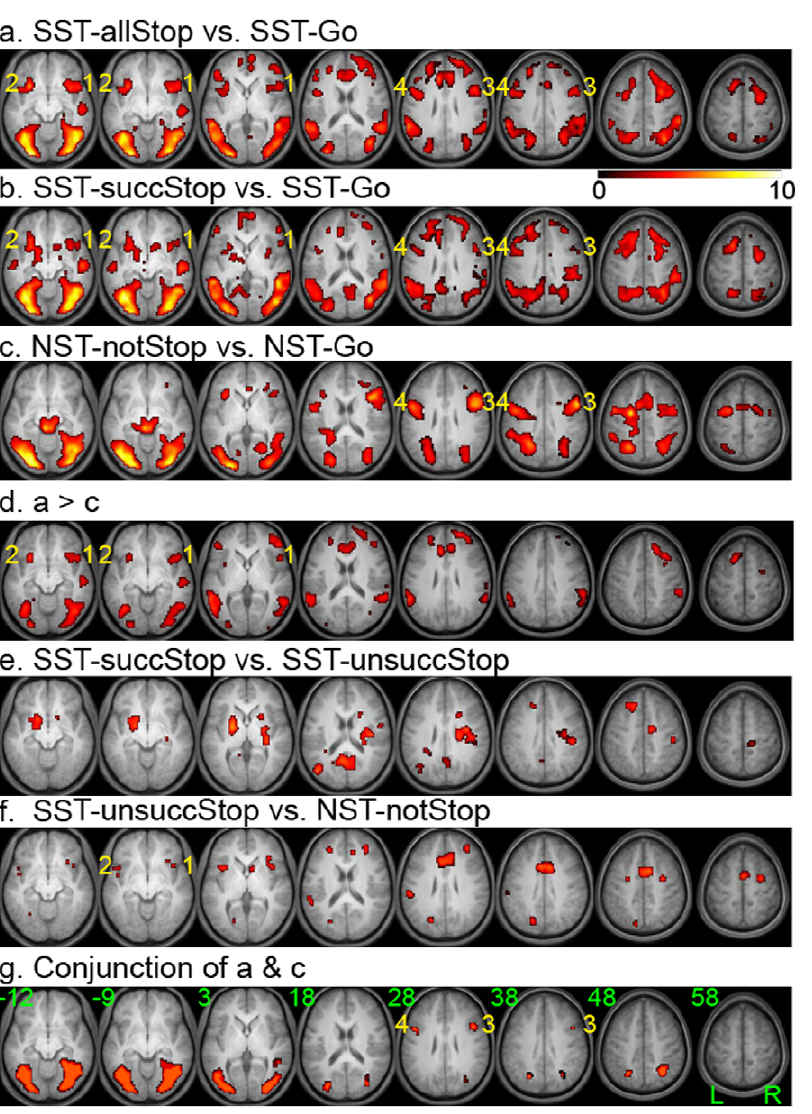
Figure 2. Group contrast maps showing transient activations during response control. a. Widespread activations shown by contrasting all stop trials and go trials of the SST. b. Activations revealed by contrasting the successful stop trials and go trials of the SST. c. Activations shown by contrasting the not-stop trials and go trials of the NST. Note that less parts of IFC showed suprathreshold activation. d. Activations revealed by directly comparing a and c. e. Activations revealed by contrasting the successful and unsuccessful stop trials of the SST. f. Activations revealed by contrasting the unsuccessful stop trials of the SST and the not-stop trials of the NST. These two types of trials were similar in both frequency and motor output. g. Conjunction maps showing activations that are suprathreshold in both contrasts, SST-allStop versus SST-Go and NST-notStop versus NST-Go. Within the IFC, suprathreshold activation was only observed in the dorsal posterior IFG. All the contrast maps were thresholded at p , 0.05 (FDR corrected) and overlaid on anatomical images averaged across the group. The numbers in the bottom row indicate the z level of the transverse slices in mm. Activation labels: 1, right ventral-posterior IFG; 2, left ventral-posterior IFG; 3, right dorsal-posterior IFG/IFJ; 4, left dorsal-posterior IFG/IFJ.